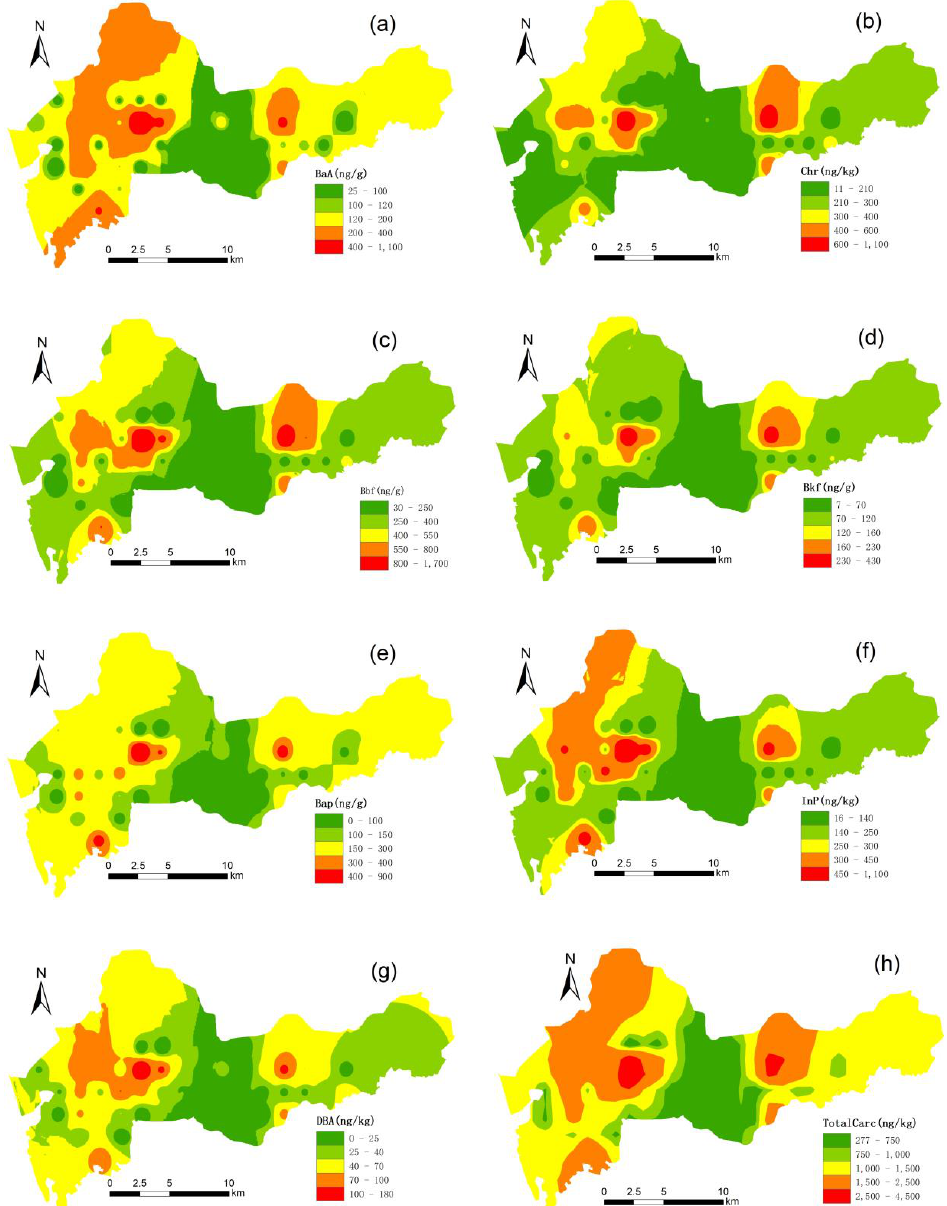
Figure 2. Spatial distribution of carcinogenic PAH concentrations (benz[a]anthracene, BaA ( a ); chrysene, Chr ( b ); benzo[b]fluoranthene, BbF ( c ); benzo[k]fluoranthene, BkF ( d ); benzo[a]pyrene, BaP ( e ); indeno[1,2,3-cd]pyrene, InP ( f ); dibenz[a,h]anthracene, DBA ( g ) and total carcinogenic PAHs ( h )).